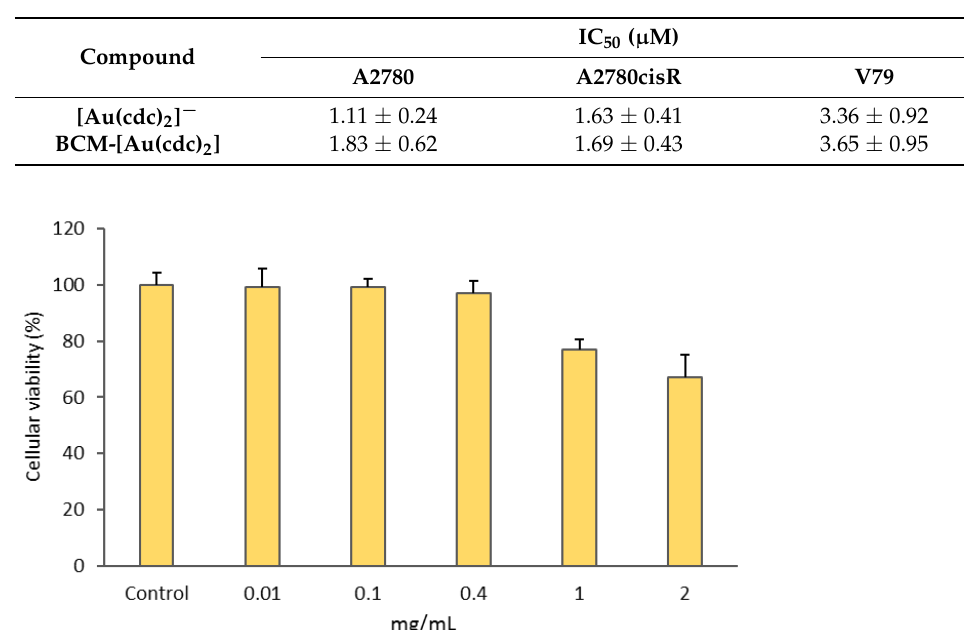
Table 5. The cytotoxic activities of [Au(cdc) 2 ] − and BCM-[Au(cdc) 2 ] after 48 h of incubation according to the MTT assay. Results are presented as the means ± SDs of at least two experiments performed with six replicates per condition.